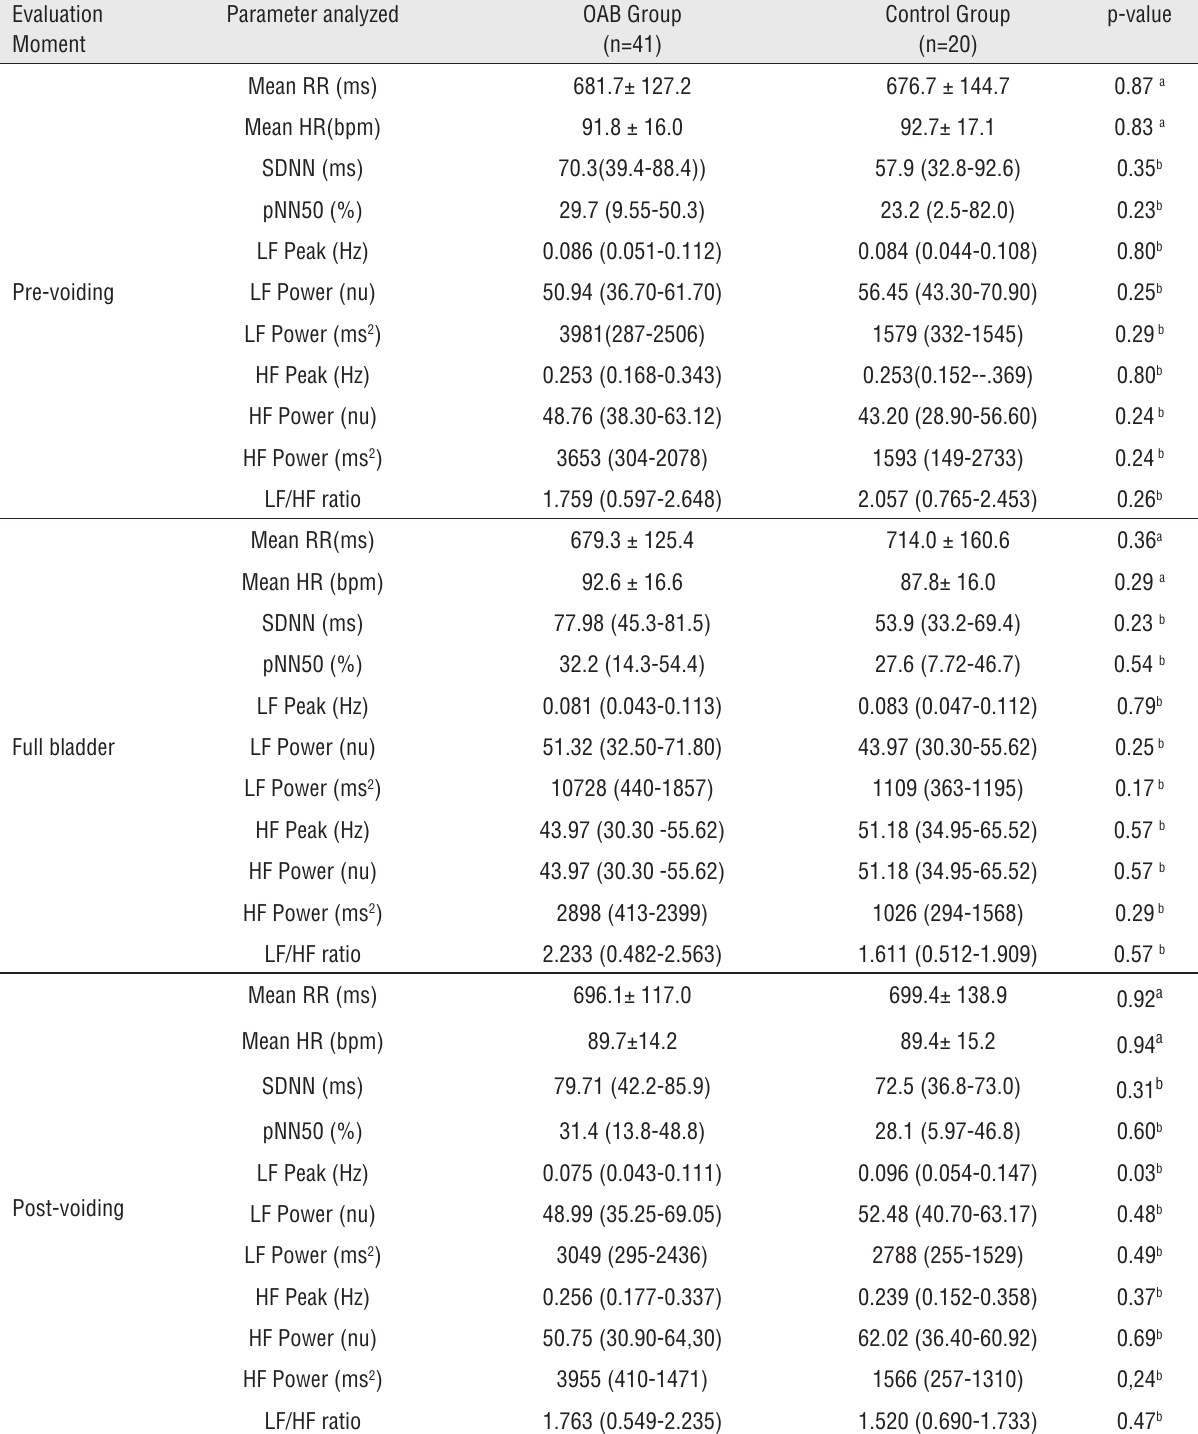
Table 4 - Comparison of heart rate variability parameters between the two study groups at three different evaluation moments: intergroup